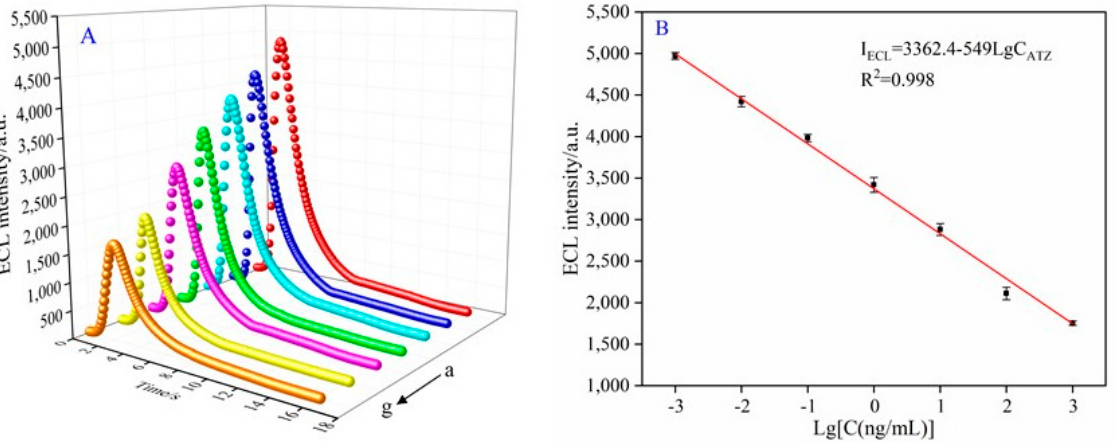
Figure 4. (A) ECL intensities of the aptasensor with different concentrations of ATZ: (a) 1 × 10 -3 ng/mL; (b) 1 × 10 -2 ng/mL; (c) 1 × 10 -1 ng/mL; (d) 1 × 10 0 ng/mL; (e) 1 × 10 1 ng/mL; (f) 1 × 10 2 ng/mL; (g) 1 × 10 3 ng/mL. (B) Calibration curve of the aptasensor for ATZ detection.